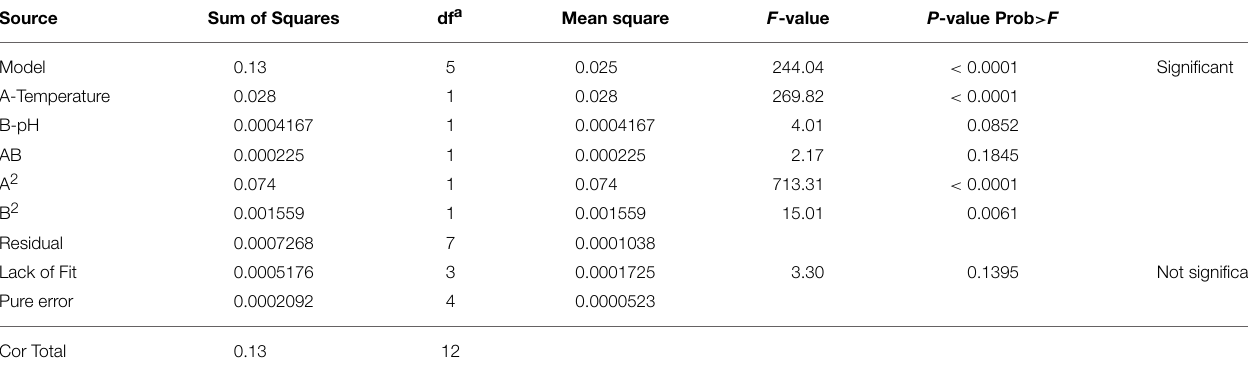
TABLE 5 | ANOVA for the experimental results of the FCCD for K. marxianus NIRE-K3. Source Sum of Squares df a Mean square F -value P -value Prob > F Model 0 . 13 244 . 04 < 0 . 0001 Significant